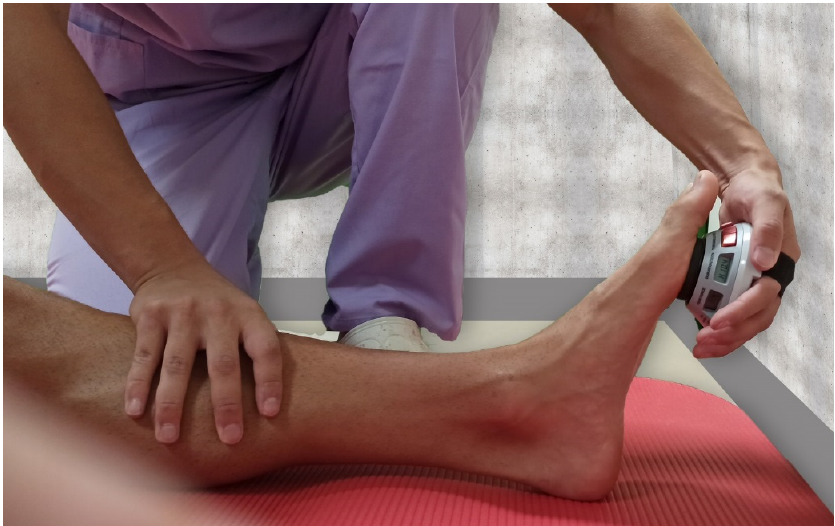
Figure 5. The isometric muscle strength testing with a manual dynamometry.